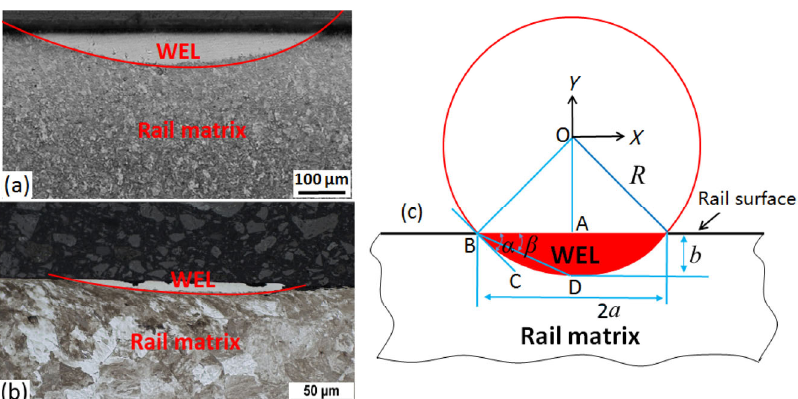
Fig. 1 Typical optical microstructure images of the WEL in the longitudinal-section: (a) in a curved track rail surface from China. Reproduced with permission from Ref. [22], © Elsevier Ltd. 2017; (b) in a straight line rail surface from Australia. (c) Schematic diagram of the WEL geometry model (definition of each parameter can be found in the